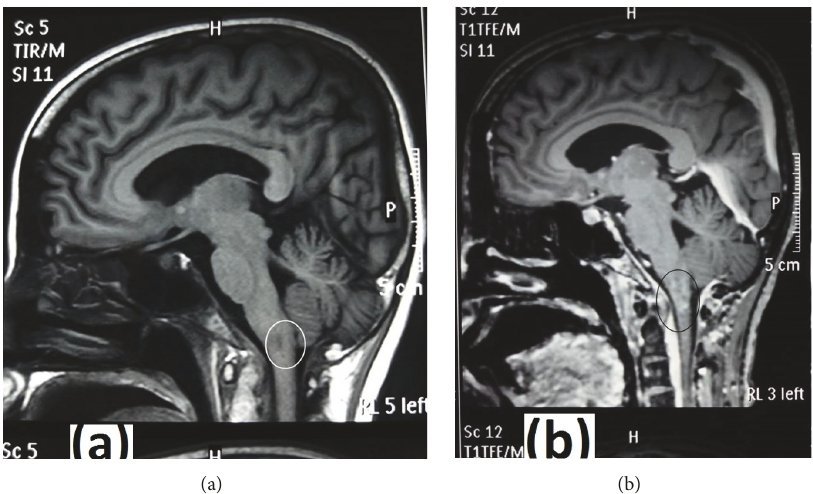
Figure 2: T1-weighted MRI of brainstem involving medulla oblongata demonstrating an infection: (a) without contrast; (b) postcontrast.